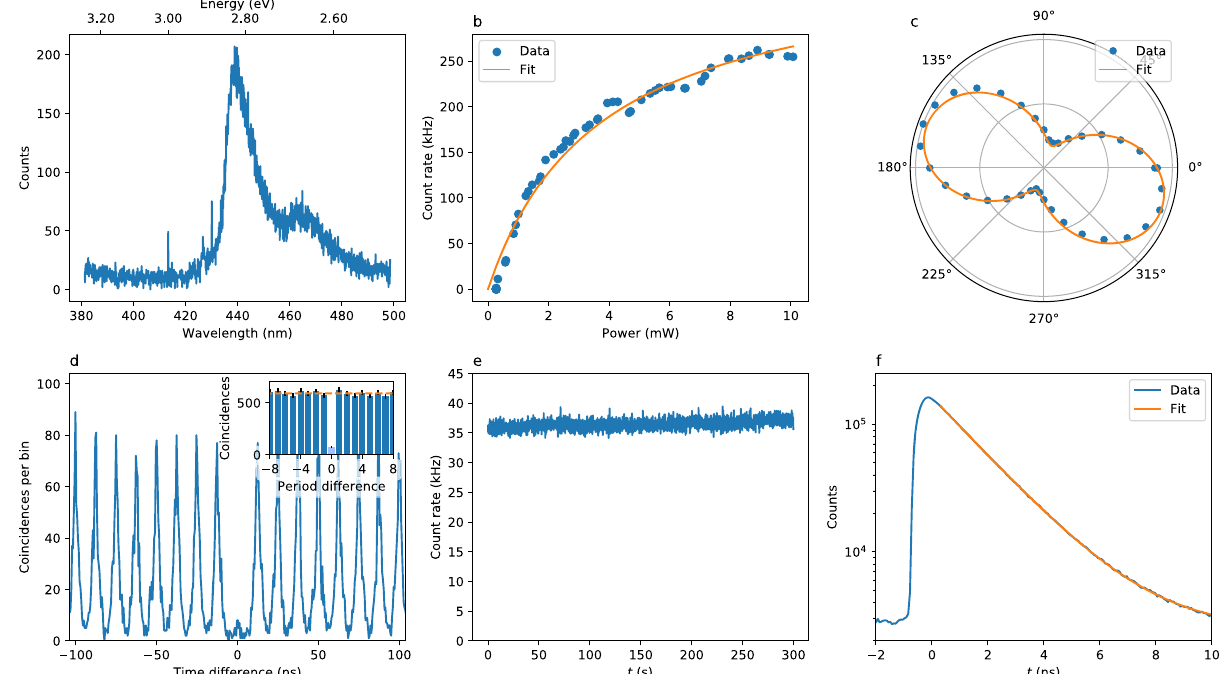
Fig. 2 Photophysical characterization of an individual SPE at room temperature. a Emission spectrum of SPE 1 , showing a main peak centred at 440 nm (ZPL) and a phonon replica at 465 nm. b Count rate as a function of the laser power in cw regime. The orange curve is a fi t to the data, from which we extract a saturation power of 3.7 mW and a maximum photon detection rate of 3.6 × 10 5 Hz. c Count rate as a function of the angle of a polarizer placed before the detector, showing linearly polarized emission. The orange curve is a sine fi t of the data. d Photon correlations in pulsed regime measured with 315 μ W excitation power and 80 MHz repetition rate, yielding g (2) (0) = 0.12 ± 0.01 and thus demonstrating single photon emission. Inset: period-wise integrated coincidences (error bars: 1 standard deviation). The dashed orange line denotes the classical limit. e Time trace of the photon detection rate with 100 ms binning, calculated from the same raw data as ( d ). f Fluorescence decay in logarithmic scale, extracted from the same raw data as ( d ). The orange curve is an exponential fi t to the data, yielding τ = 1.85 optical phonon replica is visible around 465 nm. Figure 2b shows the count rate as a function of the laser power. The emission exhibits a saturation behaviour characteristic of two-level systems.